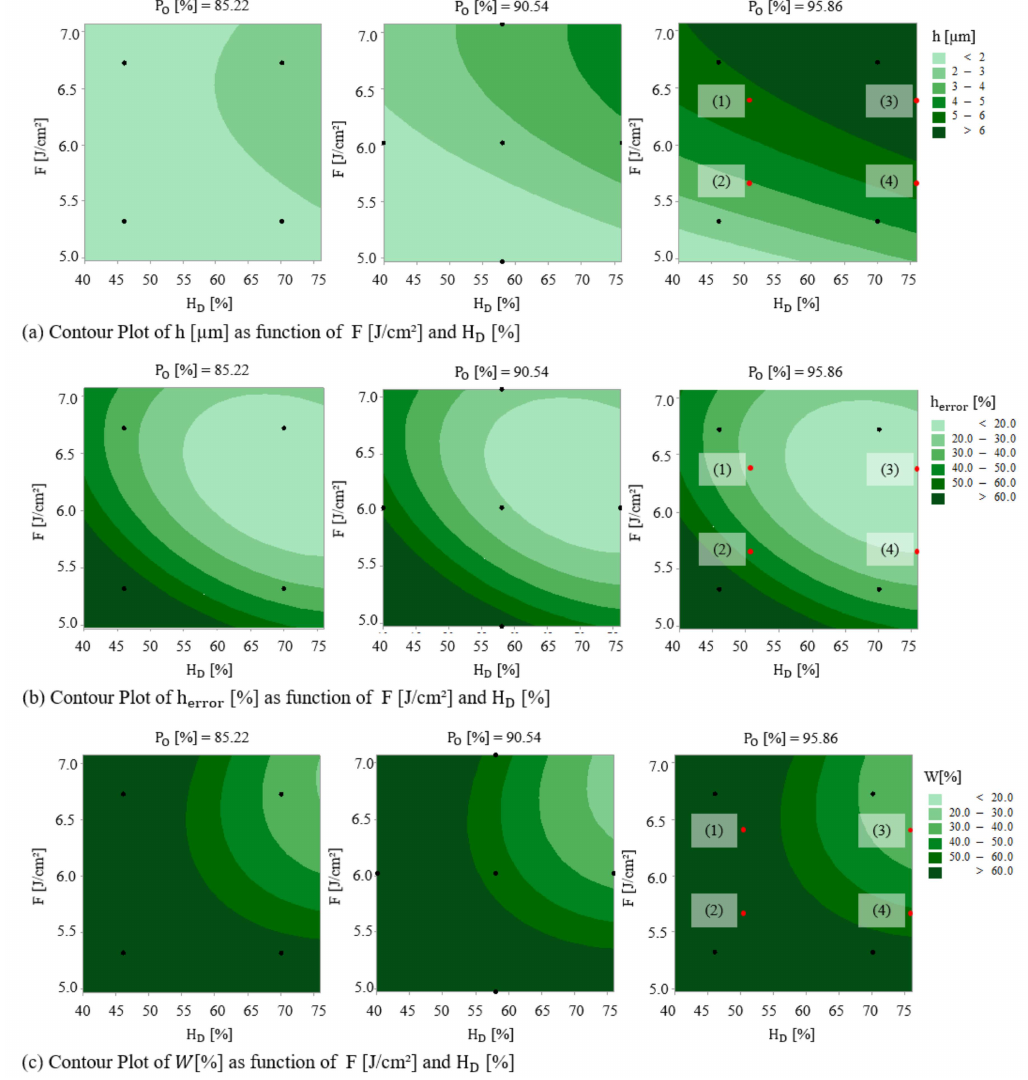
Figure 8. Contour plots of ( a ) height, ( b ) height error, and ( c ) surface